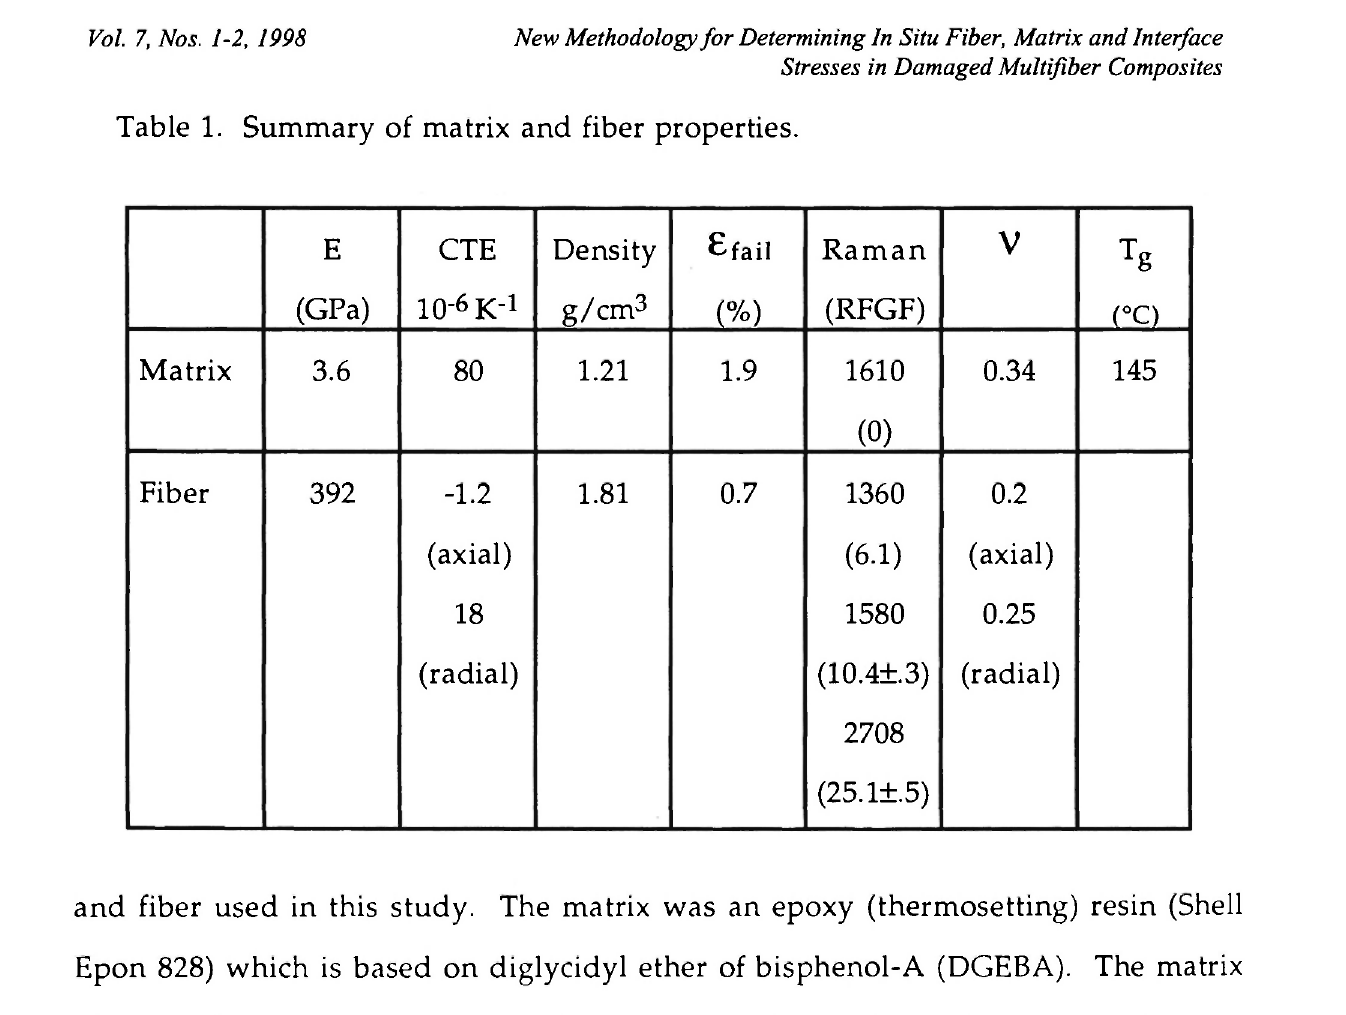
Table 1. Summary of matrix and fiber